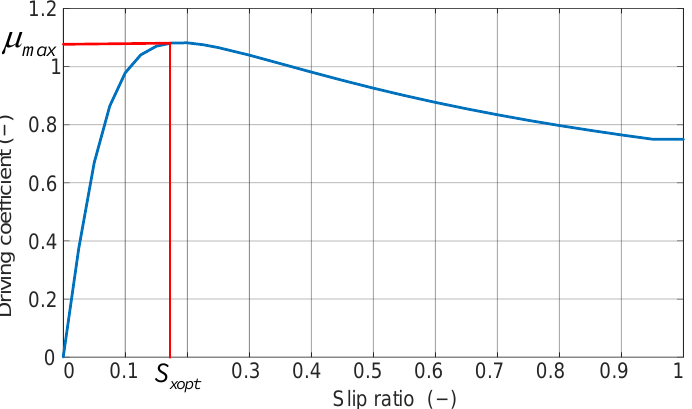
Figure 3. Driving coefficient on road surface with adhesion coefficient of 1.0.